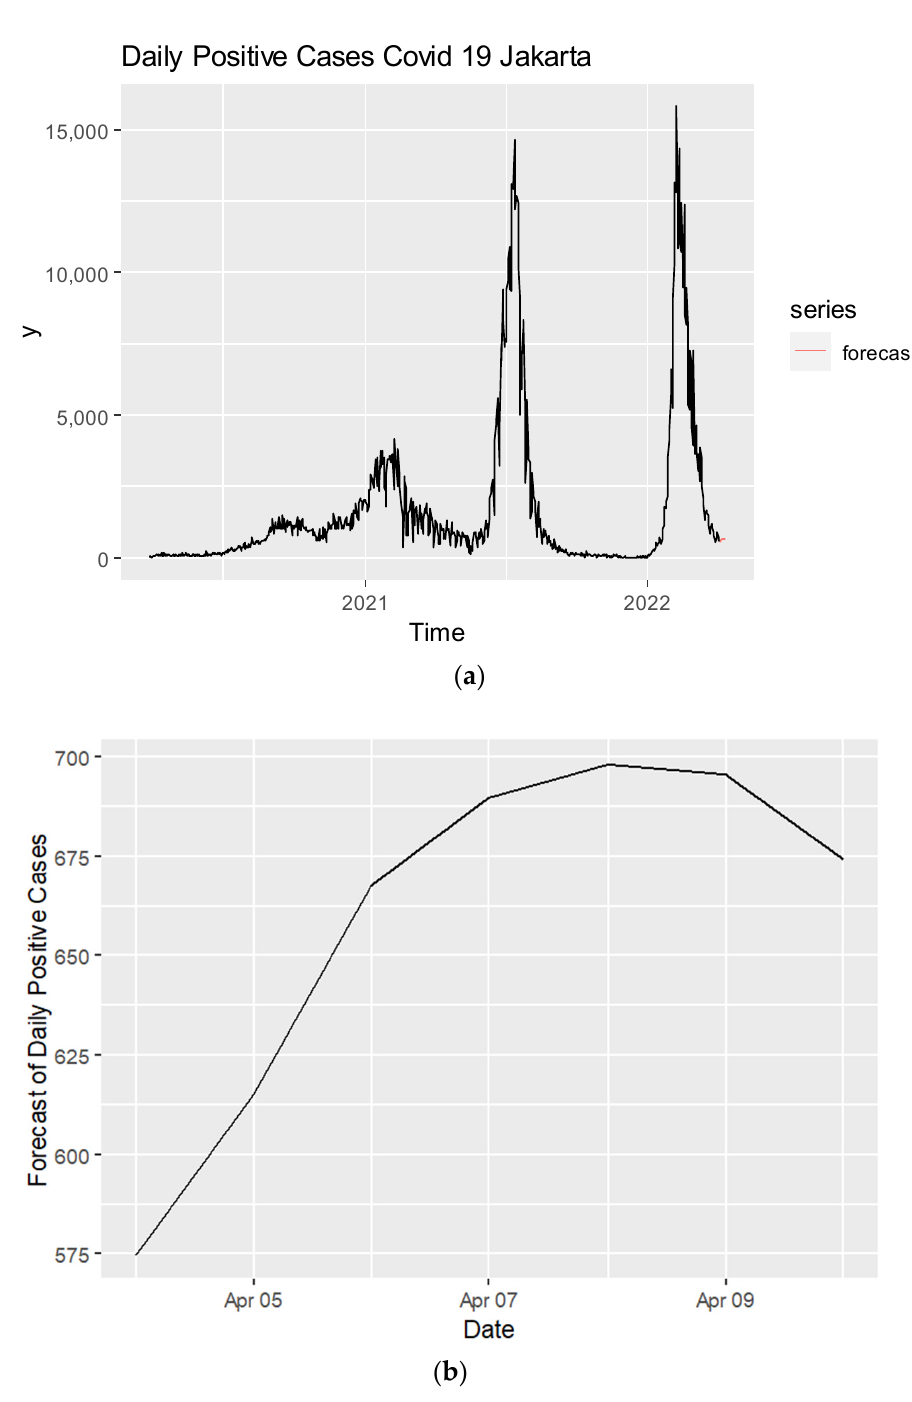
Figure 9. ( a ) Daily confirmed positive cases of COVID-19 in Jakarta and prediction for the next seven periods; and ( b ) forecast plot of daily confirmed positive cases of COVID-19 in Jakarta.